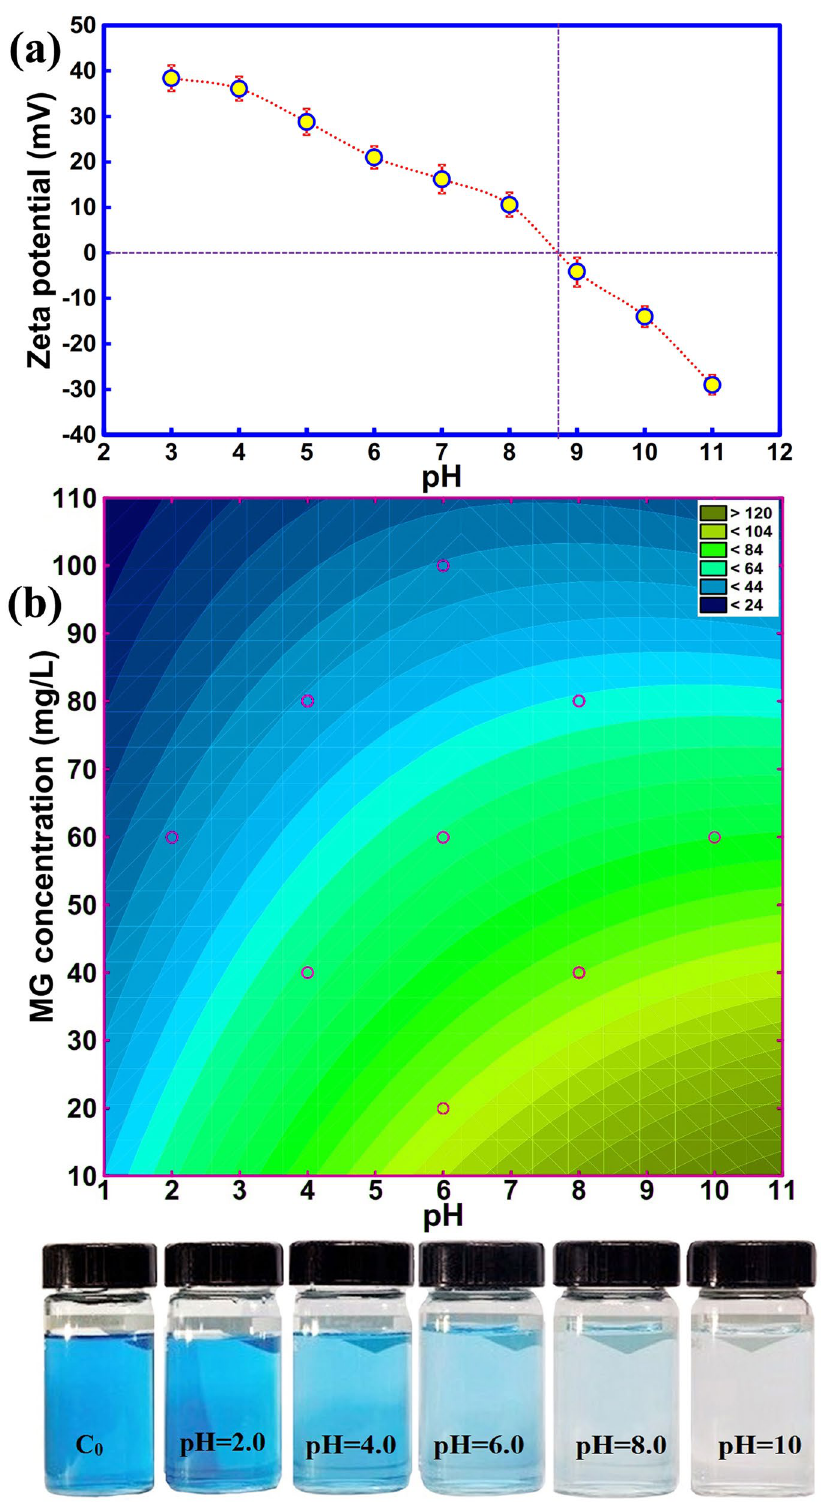
Figure 6. ( a ) Point of zero charge of meso-CaAl 2 O 4 (error bars presents ± standard deviations, n = 3), and ( b ) 2D plot showing the effect of MG concentration and solution pH on the R% of MG